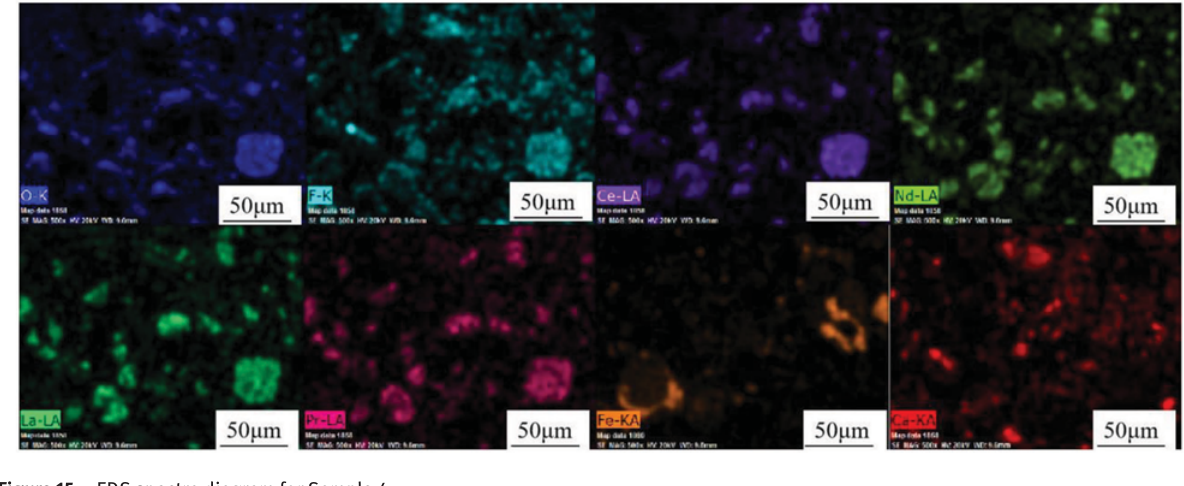
Figure 15: EDS spectra diagram for Sample